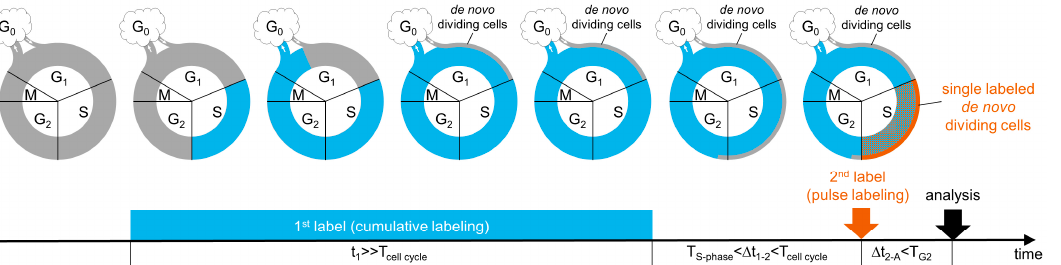
Figure 1. Labeling scheme for the unequivocal detection of de novo dividing stem cells. G 1 , S, G 2 and M: phases of the cell cycle. G 0 : a state outside the cell cycle. t 1 : duration of cumulative labeling with the first nucleotide analogue. ∆ t 1–2: a time window between the termination of cumulative labeling with the first nucleotide analogue and pulse labeling with the second nucleotide analogue. ∆ t 1-A : a time window between pulse labeling with the second nucleotide analogue and the collection of samples for analysis. Details are in the main text.